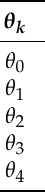
Table 7. The values of θ k from MCS by gradient